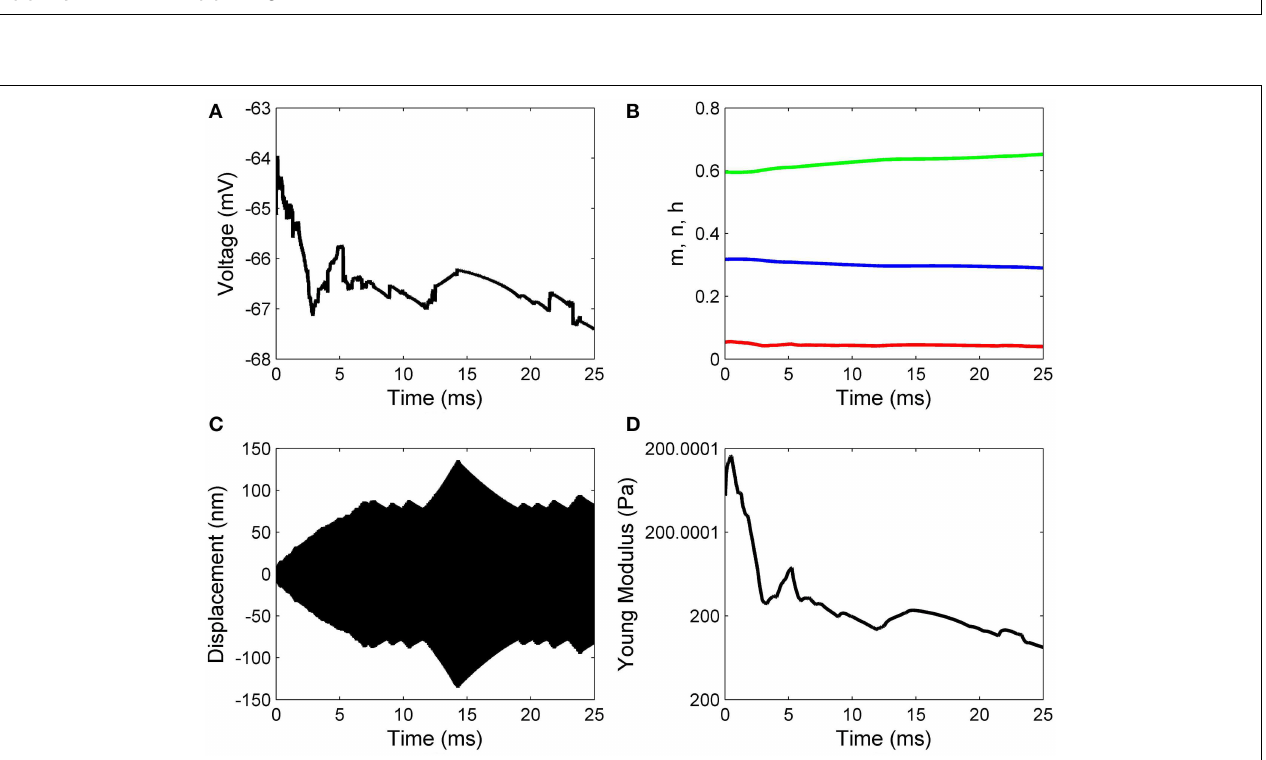
FIGURE 3 | Results for zero initial displacement and initial speed of 1nm/ µ s: (A) voltage, (B) functions n (blue line), m (red line), and h (green line), (C) displacement, and (D) Young’s modulus.